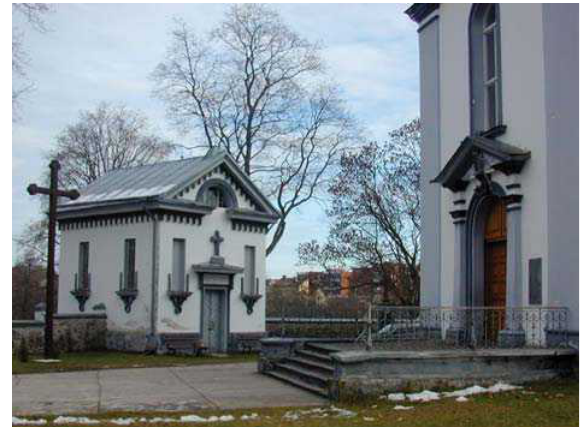
Fig 2. Church of St Michael Archangel and Parczewski family chapel in